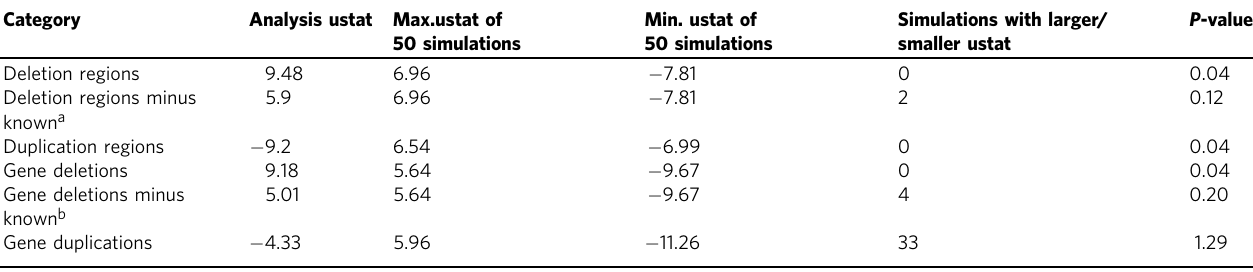
Table 6 Direction of effect